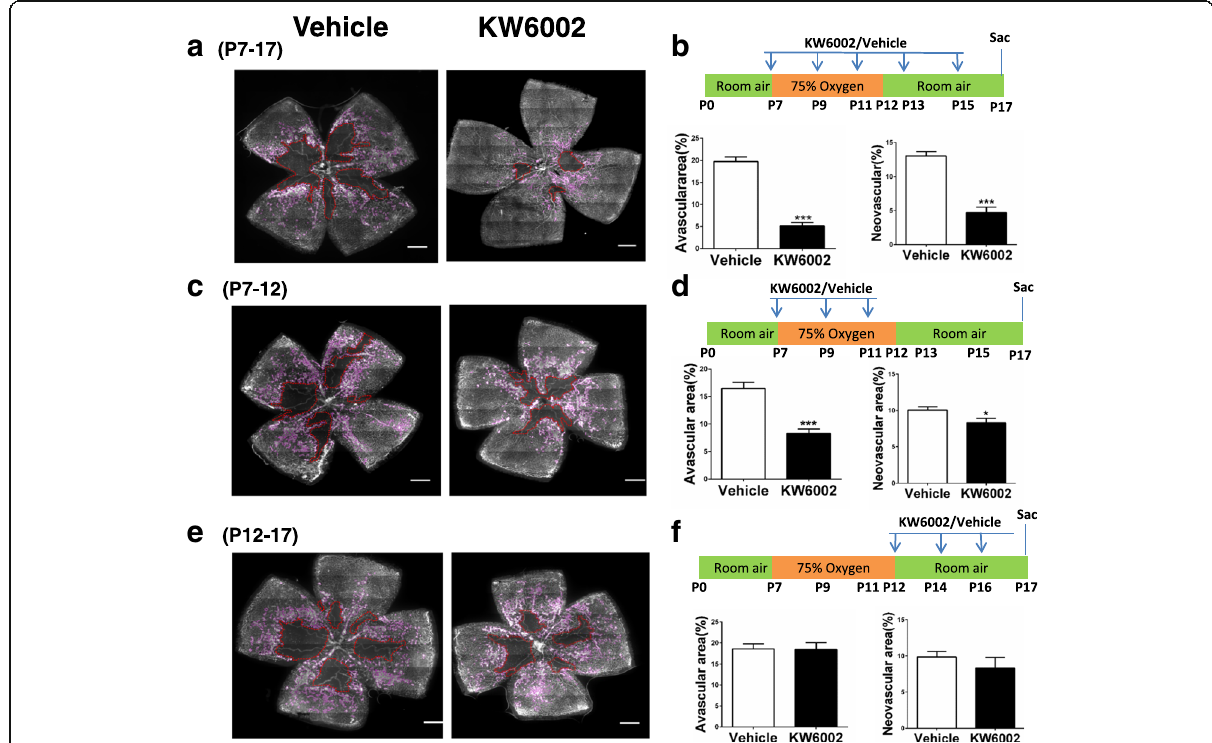
Fig. 4 Effective therapeutic windows for KW6002 to confer protection against OIR. a , c , e Pups were treated with KW6002 (10 mg/kg) in different developmental stages (P7 – 17, P7 – 12, and P12 – 17) and retinal vasculatures were analyzed by whole-mount isolectin B4 staining at P17 of OIR. Avascular areas are shown by red dotted line. Neovascularization tufts are indicated by purple line. Scale bar: 500 μ m. b , d , f Schematic of the experimental design: KW6002 was administered by intraperitoneal injection at volume of 10 mg/kg at different postnatal developmental stages (P7 or P12) and for different period (P7-P17, P7-P12 or P12-P17) every other day. OIR mice were euthanized at P17. b , d , f Avascular area (%) was quantified as a percentage of the whole retinal surface ( n = 7 – 9/group). The neovascularization tufts area (%) was quantified as a percentage of whole retinal area ( n = 7 – 9/group). *** p < 0.001, * p < 0.05, Student ’ s t-test or Mann-Whitney U test, n = 7 –